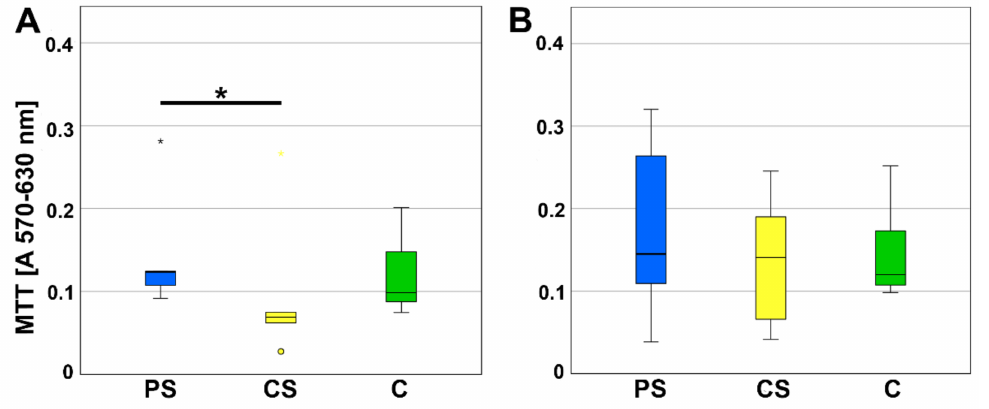
Figure 1. MTT assay ( A ) after 3 (d) and ( B ) 6 days of incubation. CS—compact scaffolds, PS—porous scaffolds, C—control on cell culture plastic. * indicates a statistically significant likelihood of p ≤ 0.05. Circles and small asterisks denote outliers.